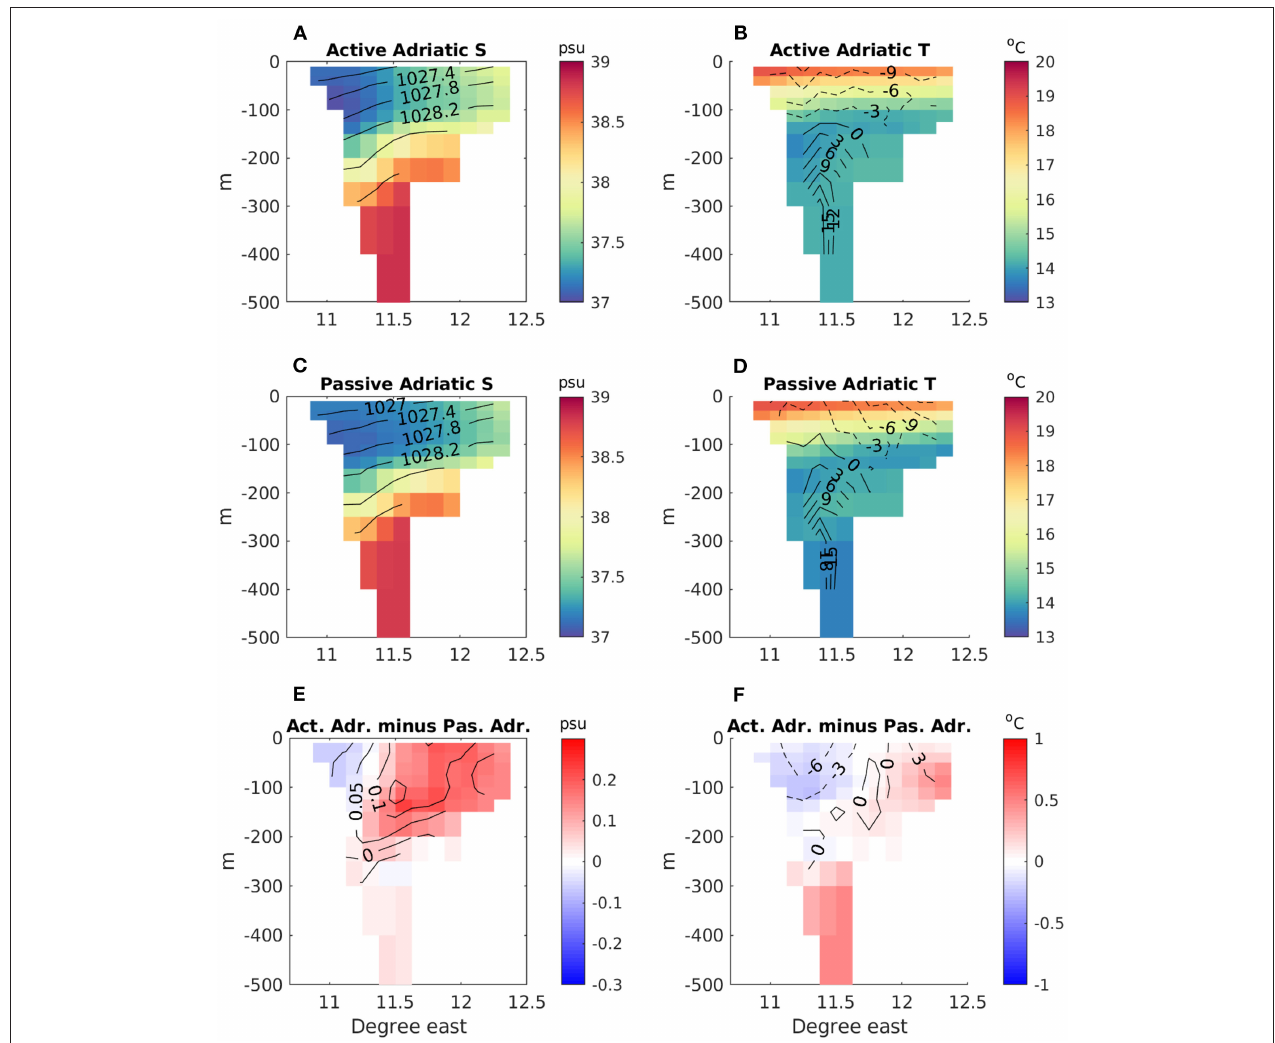
FIGURE 4 | Five-year means of salinity (left) and temperature (right) of water passing through the Sicily Strait along the transect plotted in Figure 1 . Contours of density (left) and velocity (right) along the transect are superimposed, in an active Adriatic state (A,B) , passive Adriatic state (C,D) , and their difference (E,F) . The dashed (negative) lines indicate southward flow, while the solid (positive) lines indicate northward flow. The density is given in units of kg / m 3 and the velocity in units of cm / s